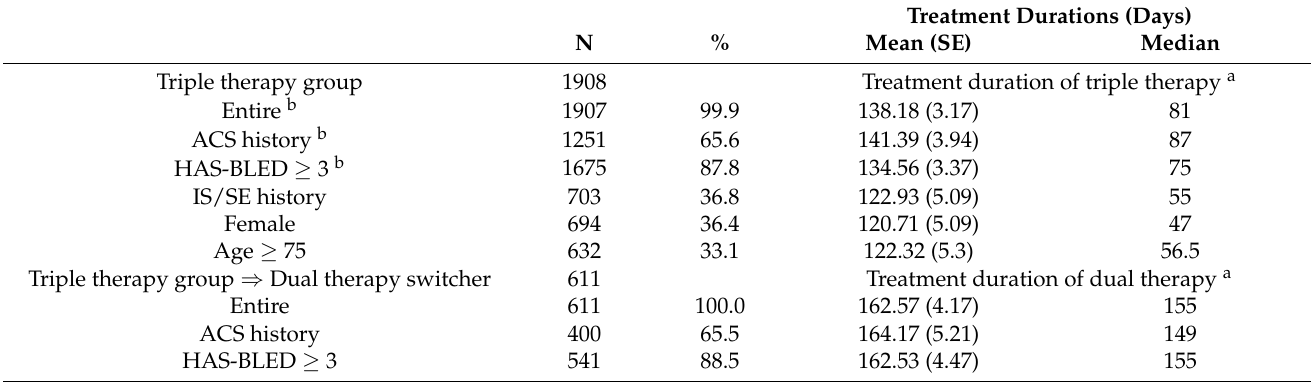
Table 3. Treatment duration (days) in patients with triple therapy or dual antiplatelet